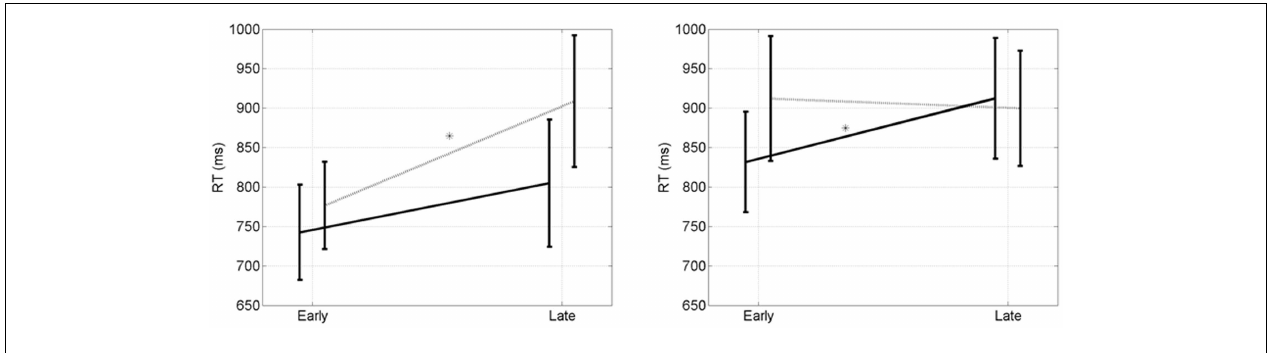
corrects.There is a significant early to late increase when participants are primed “stupid” ( p = 0.03, solid line, *), but not when they are primed “clever” ( p = 0.39, dotted line). Error bars indicate the standard error of the mean.